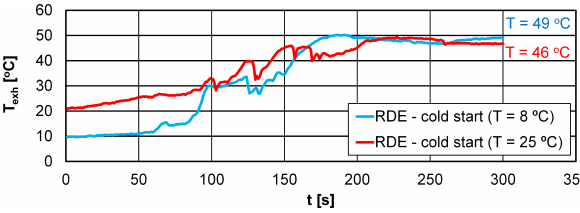
Figure 5: The exhaust gas temperature after the cold start at differ- ent ambient